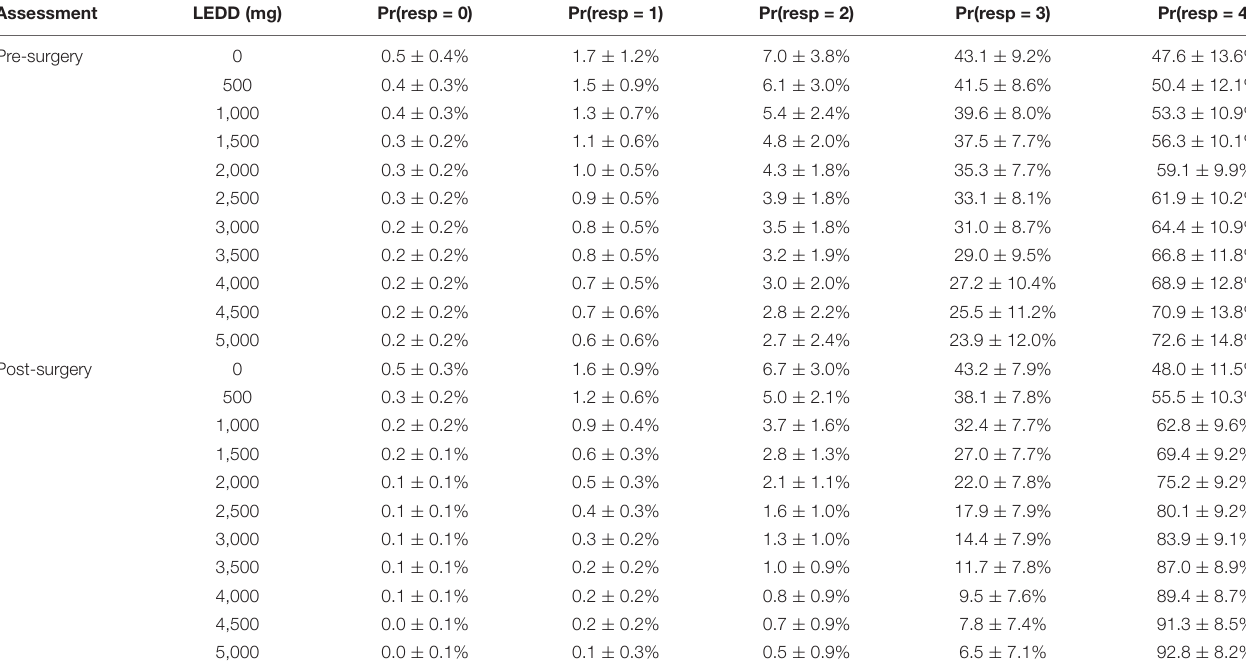
TABLE 3 | Expected response probabilities of difficulty in IADL stratified by the time of assessment and levodopa equivalent daily dose derived from the ordered-logit GLMM.